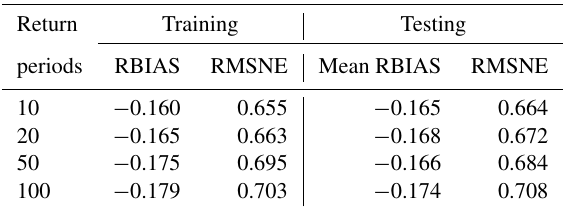
Table 4. Result for different return period flood